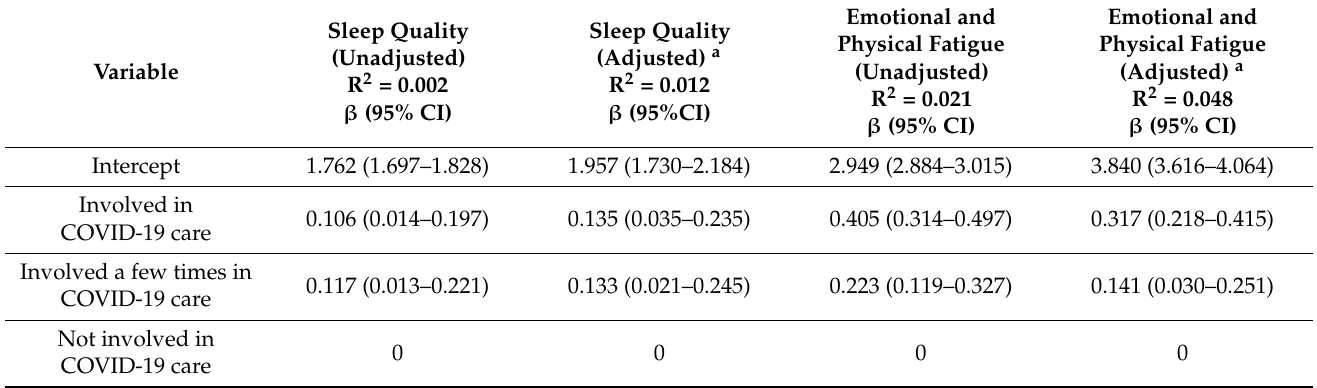
Table 3. Associations between involvement in COVID-19 care and health consequences (sleep quality and emotional and physical fatigue) among health-care workers (N =